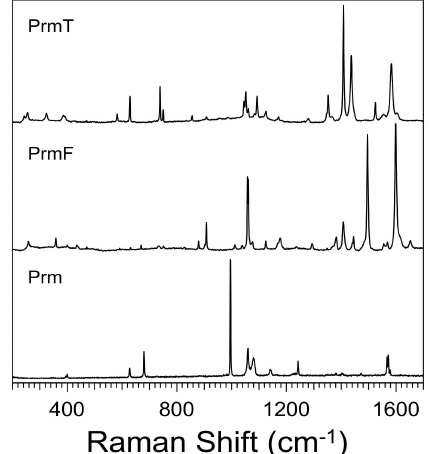
Figure 2. Experimental solid-state Raman spectra of pyrimidine (Prm) compared to that of its furan (PrmF) and thiophene (PrmT) analogues in the fingerprint region.